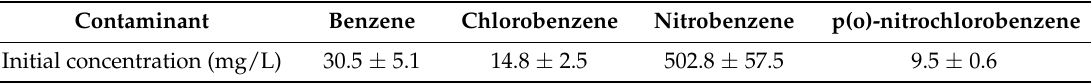
Table 2. The initial concentration of the main contaminants in groundwater.